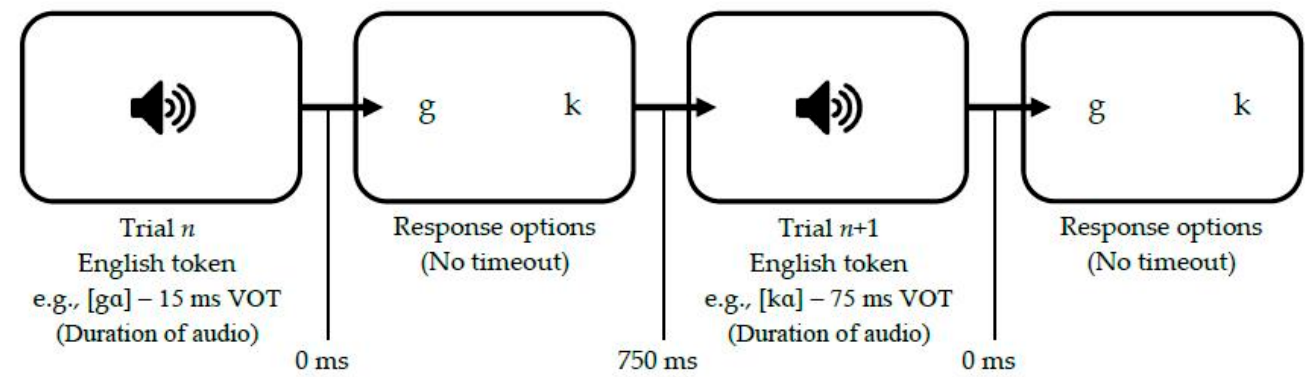
Figure 7. Trial design for the L1 English identification experiments.